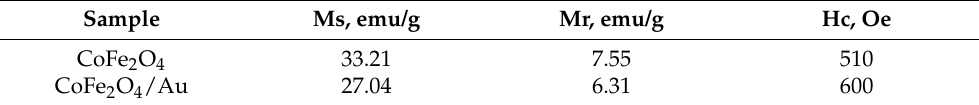
Table 3. Magnetic parameters obtained from the results of magnetic hysteresis loops in Figure